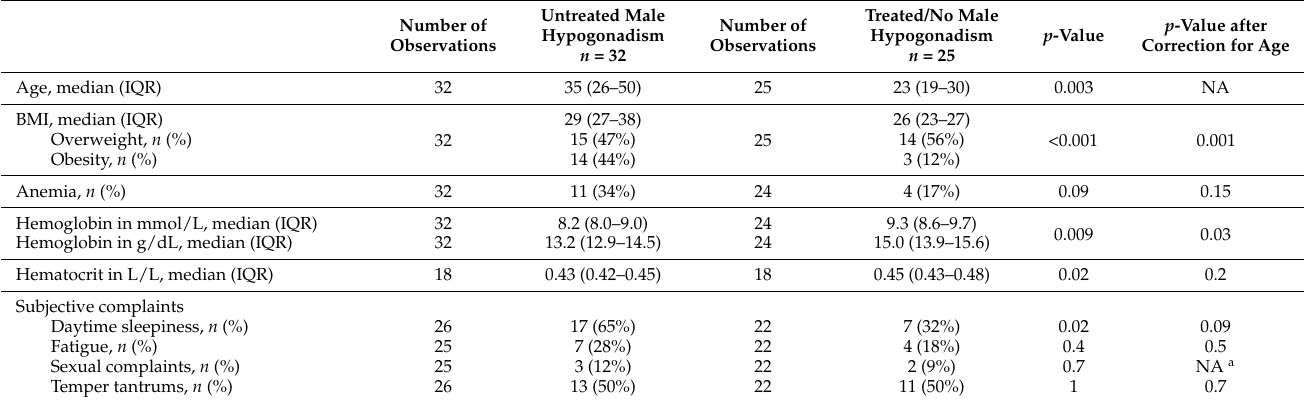
Table 3. Effect of untreated hypogonadism in adult males with PWS.